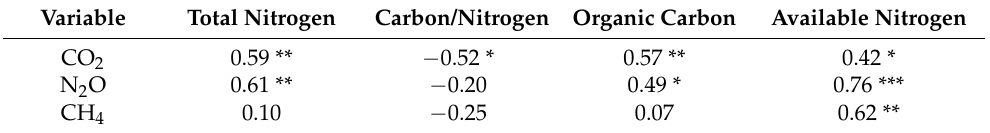
Figure 3. Effects of manure type on ( a ) CO 2 , ( b ) N 2 O, ( c ) CH 4 , and ( d ) total GHG fluxes (sum of CO 2 , N 2 O, and CH 4 ) across three soil types throughout the incubation. Soil type: OBC, Orthic Black Chernozem; OGL, Orthic Gray Luvisol; and DBC, Dark Brown Chernozem. Manure type: CM, manure from cattle fed a corn silage-based backgrounding diet; BM, manure from cattle fed a barley silage-based backgrounding diet; and CK, control (soil without amendments). Vertical bars indicate standard errors of the means ( n = 4). Table 3. Spearman’s rank correlation coefficients of relationships between the cumulative CO 2 , N 2 O, and CH 4 emissions and the initial amended and non-amended soil properties across the three soils (on day 1 of the incubation) ( n = 12). * p < 0.05; ** p < 0.01; *** p < 0.001.